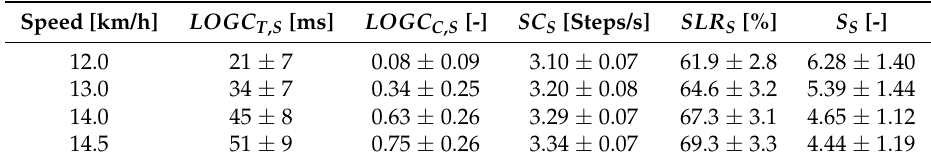
Table 9. Infringements ( LOGC T , S , LOGC C , S ) and performance ( SLR S , SC S , S S ) parameters evaluated for 864 step sequences, corresponding to 25,920 steps (mean